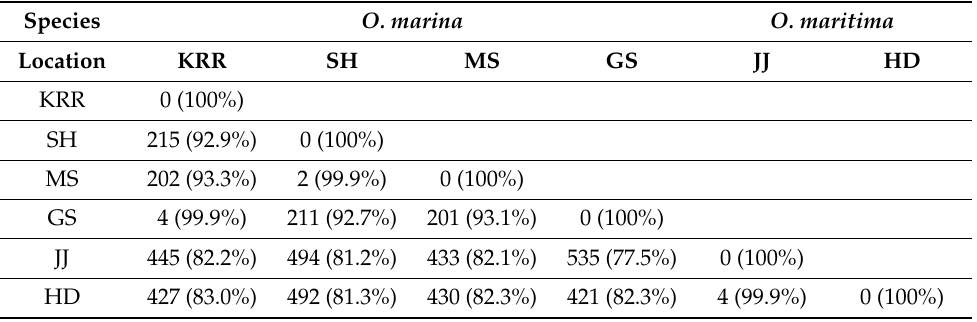
Table 3. Comparison of the total sequences of O. marina (KRR, SH, MS, GS) and O. maritima (JJ and HD). The numbers are base pairs different from each other. The numbers in parenthesis are similar (%) except